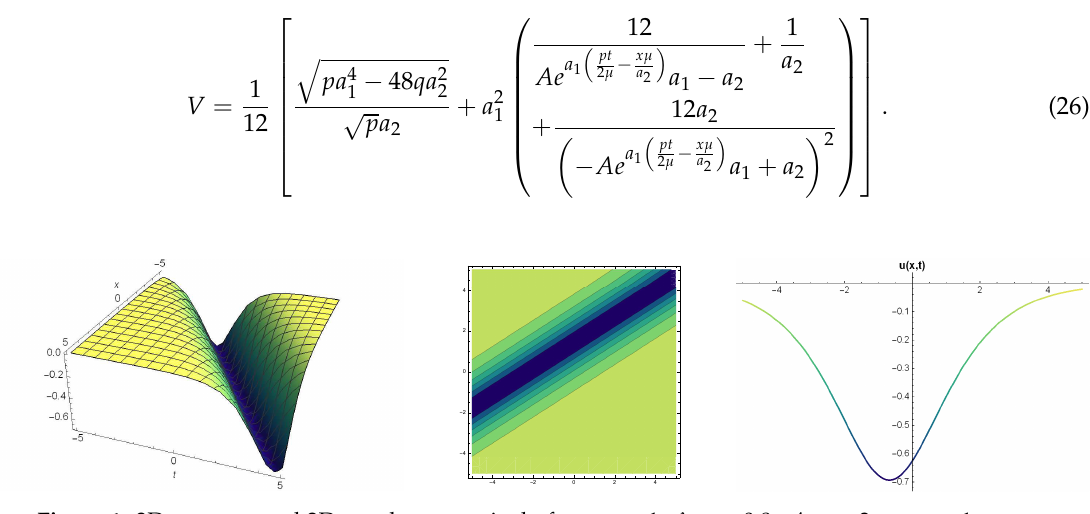
Figure 1. 3D, contour and 2D graphs respectively for p = − 1, λ = − 0.8, A = − 3, a 0 = − 1, a 1 = − 1, q = 2 values of Equation